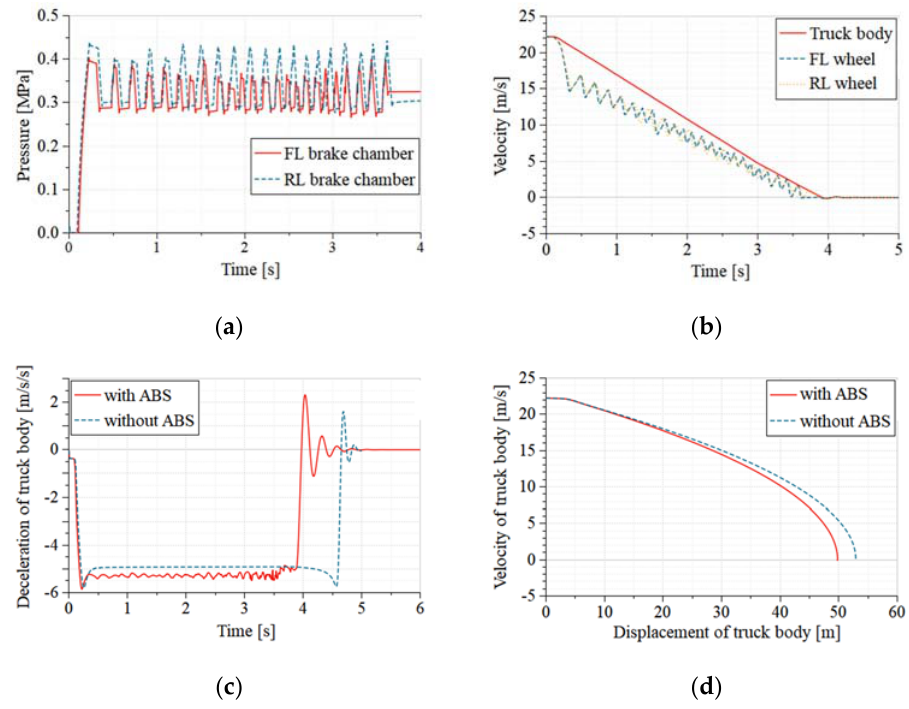
Figure 16. Braking characteristics on the road with adhesion coefficient 0.6. ( a ) Pressure of brake chamber; ( b ) velocity of truck body and wheels; ( c ) deceleration of truck body with ABS and without ABS; ( d ) velocity-displacement curves of truck body with ABS and without ABS.